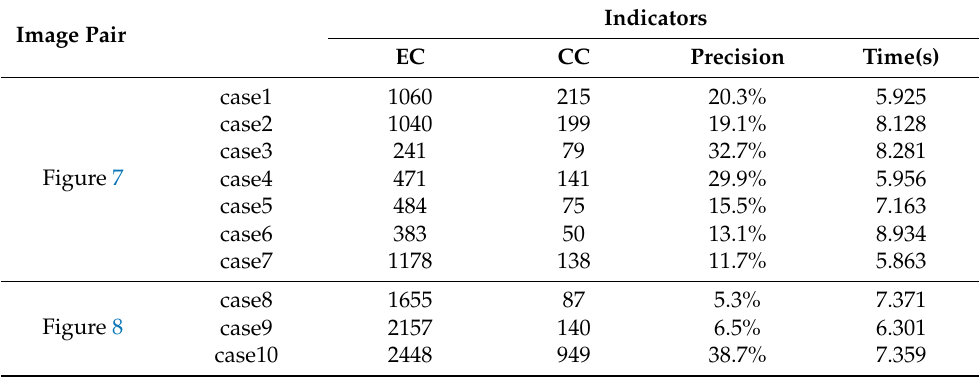
Table 3. Multi-source image matching results for ten